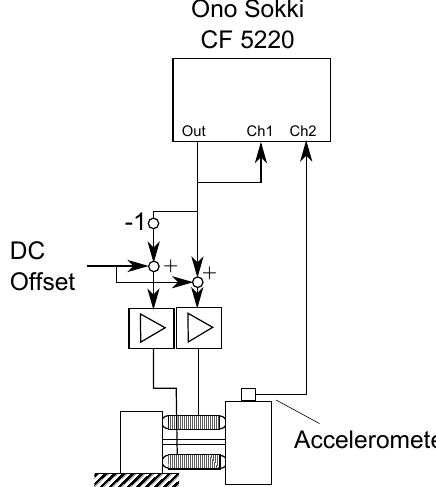
Figure 11. Test set up for the measurement of the dynamic block force of the actuator.